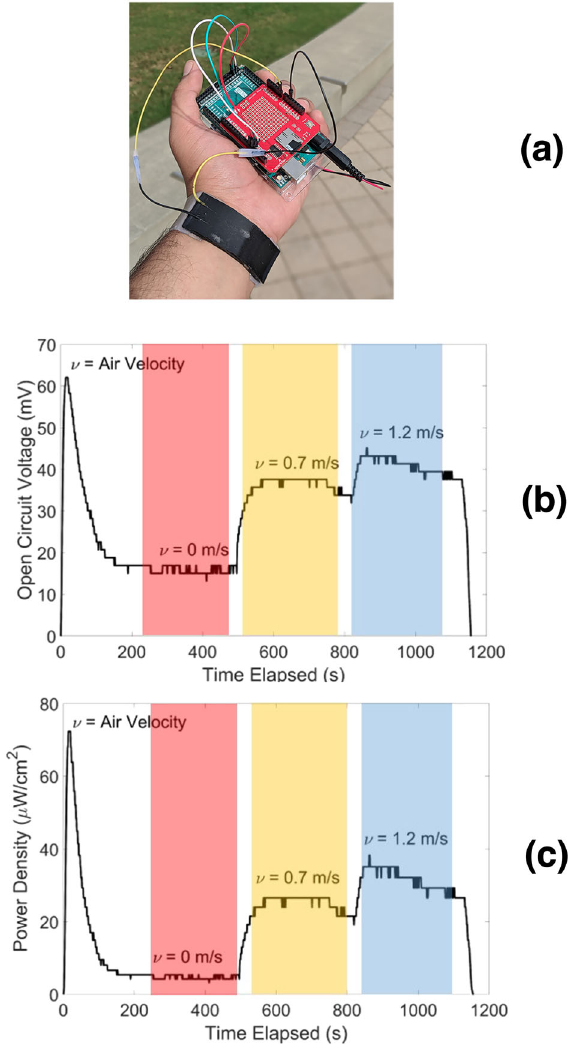
Fig. 8 Characterization of fl exible TEGs on the wrist. a A fl exible TEG worn on the wrist and the hand-held recording device. b Open- circuit voltage versus time measured on the wrist for three different air velocities of 0, 0.7, and 1.2 ms − 1 . c Corresponding power density values plotted against